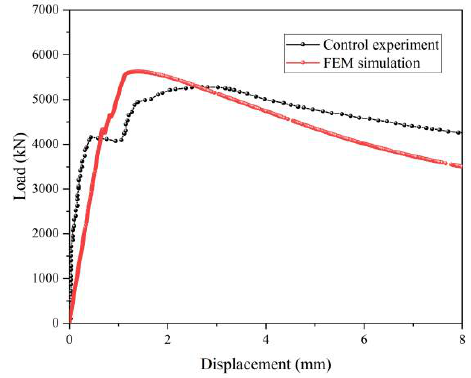
Figure 6. Comparison of simulation and experiment.